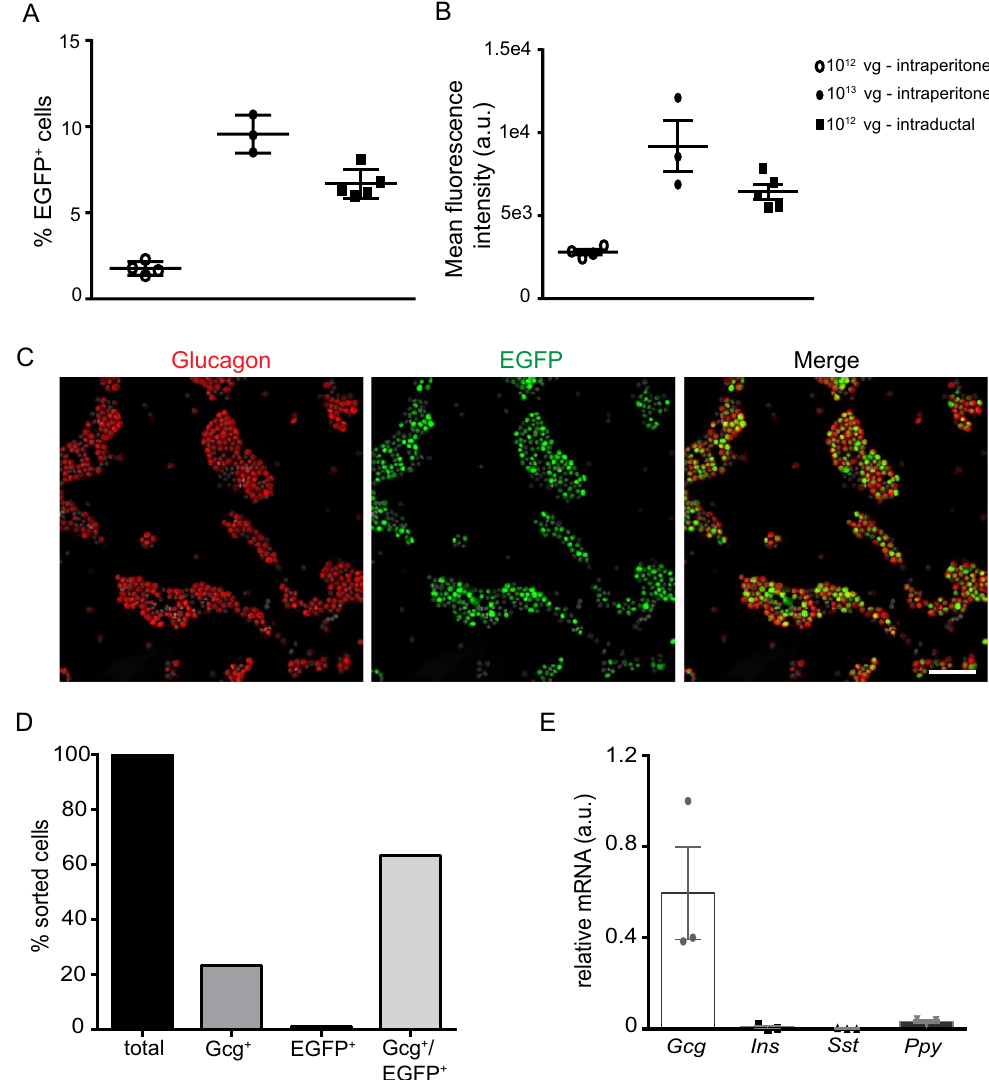
Figure 2. Administration of AAV GCG-EGFP allows for cell sorting of α -cells. ( A ) Percentage of total islet cells and ( B ) mean fluorescence intensity of EGFP + cells, sorted based on EGFP fluorescence, after either intraperitoneal administration of 10 12 (n = 4) and 10 13 vg (n = 3) or intraductal administration of 10 12 vg (n = 5) of AAV GCG-EGFP. ( C ) Immunocytochemistry for glucagon (red), GFP (green) and DAPI (grey) in a population of islet cells sorted after intraperitoneal administration of 10 12 vg AAV GCG-EGFP and ( D ) percentage of glucagon positive GFP negative (GCG + ), glucagon negative GFP positive (GFP + ), and both glucagon and GFP positive (GCG + /GFP + ) cells based on immunohistochemistry of sorted cells. ( E ) mRNA levels of islet hormones in the EGFP positive fraction of sorted cells (n = 3). AAV: adeno-associated virus; EGFP: enhanced green fluorescent protein; vg: viral genomes; GCG: glucagon; Ins: insulin; Sst: somatostatin; Ppy: pancreatic polypeptide. Data are expressed as mean ±